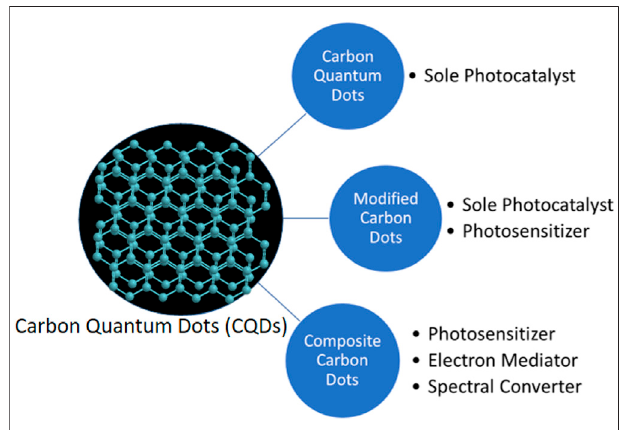
FIGURE 1 | Schematic overview of applications of CQDs-related materials as sole photocatalysts, photosensitizers, electron mediators, and spectral